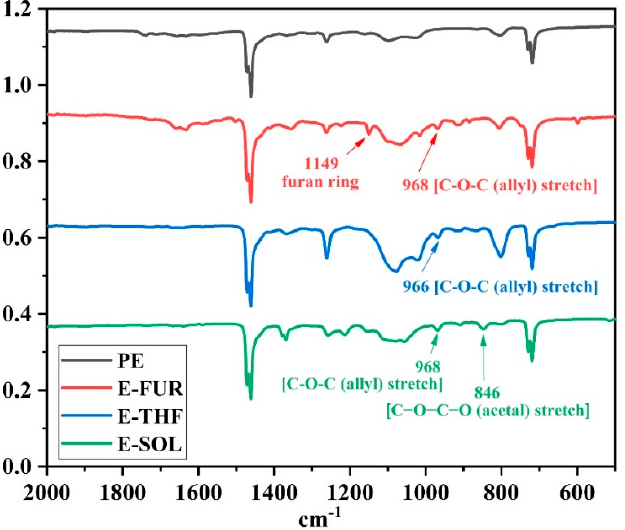
Figure 3. ATR-IR spectra of representative ethylene and 2,7-octadienyl ether copolymers (PE, black; E-FUR , red, Table 1, entry 3; E-THF , blue, Table 1, entry 4; E-SOL , green, Table 1, entry 5).